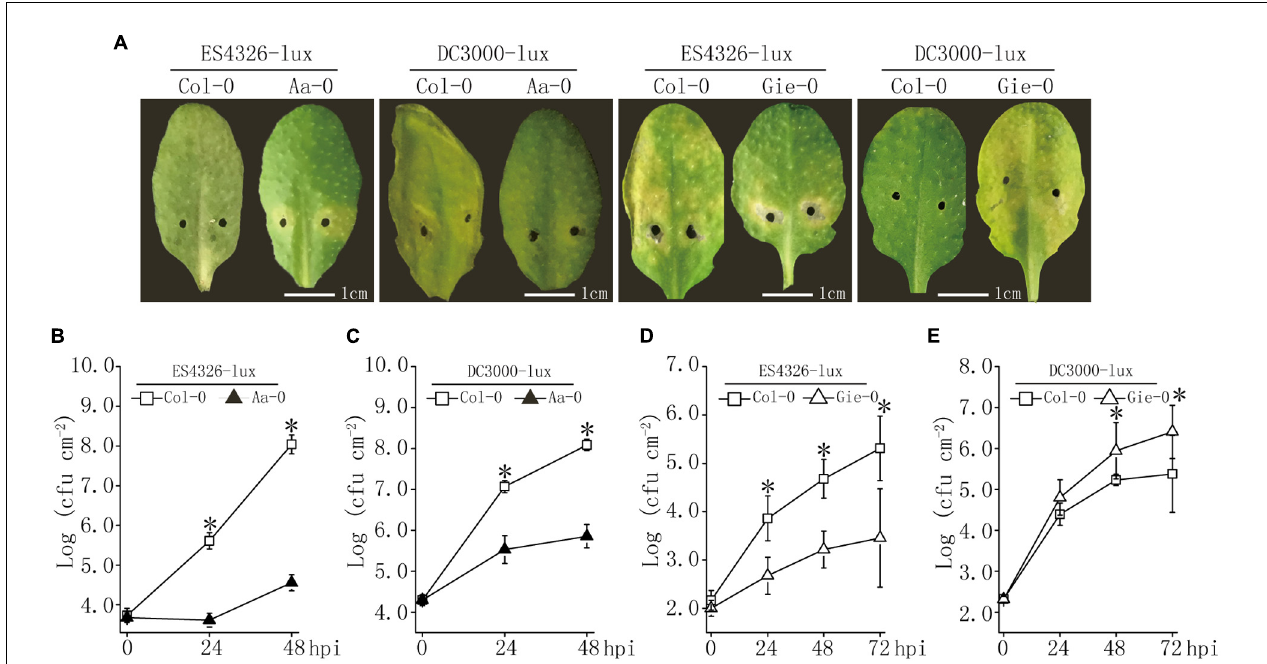
FIGURE 1 | Variation in disease resistance to Pseudomonas syringae among Arabidopsis accessions Aa-0, Gie-0, and Col-0. (A) Disease symptoms on leaves infected with lux-tagged P . syringae pathovars maculicola ES4326 (ES4326-lux) or tomato DC3000 (DC3000-lux). (B–E) Bacterial growth in planta after inoculation with ES4326-lux or DC3000-lux. Bacterial suspensions were pressure infiltrated into fully expanded leaves of 4 ∼ 5 week old Arabidopsis plants using a 1 ml needleless syringe. Bacterial inocula of optical density (OD 600 ) at 0.003 and 0.0002 were used to compare the difference in disease levels between Col-0 and Aa-0, and between Col-0 and Gie-0 plants, respectively. After inoculation, Col-0/Aa-0 plants were covered to keep high relative humidity, whereas Col-0/Gie-0 plants were left uncovered. Pictures of inoculated leaves were taken 48 and 72 hours post inoculation (hpi) for Col-0/Aa-0 and Col-0/Gie-0 plants, respectively. Asterisks indicate significant differences between the genotypes (Student’s t -test, P < 0.05). Data shown are means ± SD ( n = 8). Experiments were repeated three times with similar